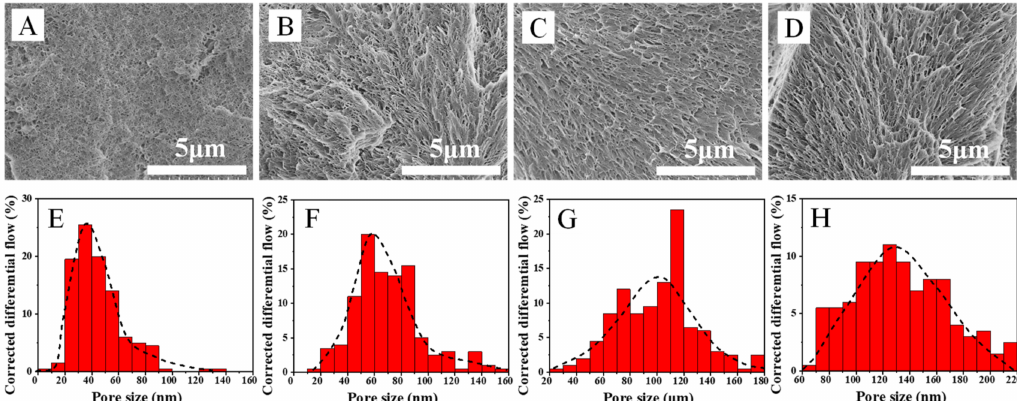
Figure 8. SEM images of PVDF/PMMA blends after chloroform etching with the different molecular weights of PMMA ( A – D ) and distribution of pore size analysis by a Nano Measurer ( E – H